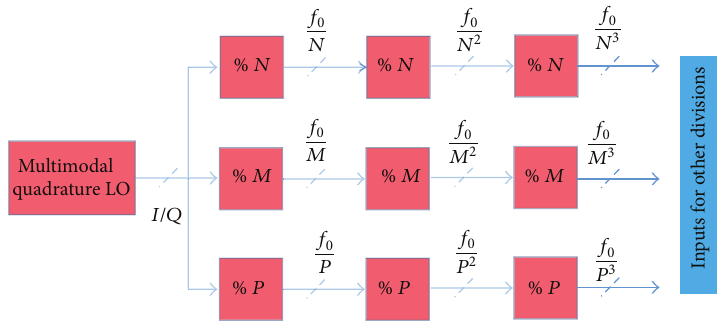
Figure 13: Multidecade carrier generation using a single multimodal